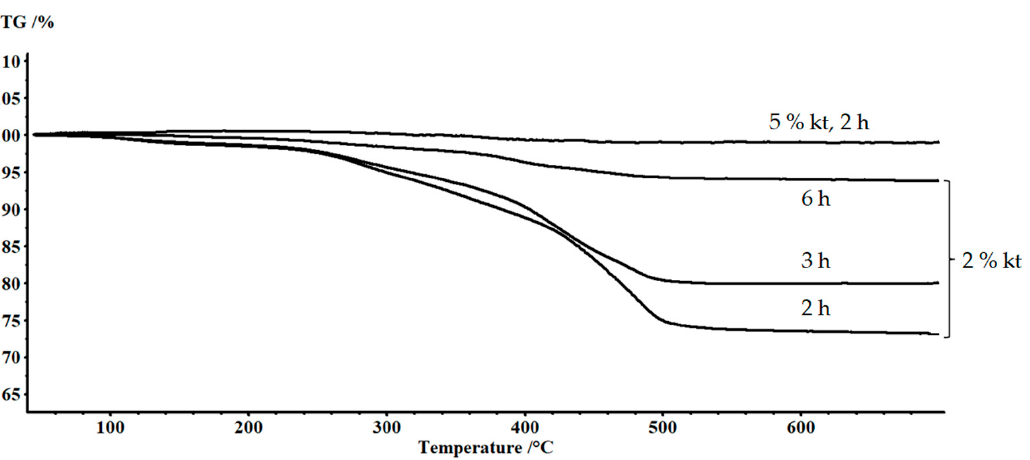
Figure 5. Curves of the relative mass ratio over time depending on the concentration of the complex (2,3,5-TPhTz) 2 [CuCl 4 ].